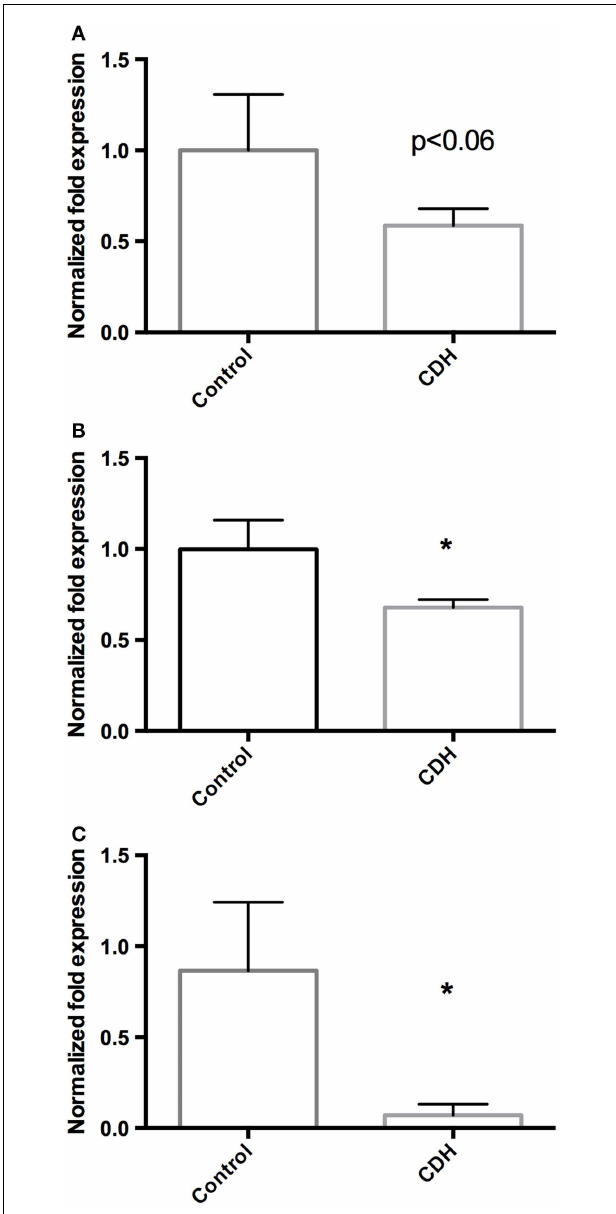
FIGURE 3 | (A) Wnt2 mRNA expression normalized to 18S.Wnt2 expression was decreased in CDH lungs ( n = 3) compared with controls ( n = 5, p < 0.06), (B) BMP4 mRNA expression normalized to 18S. BMP4 expression was significantly decreased in CDH lungs ( n = 3) compared with controls ( n = 5, * p < 0.05), (C) LGL1 mRNA expression normalized to 18S. LGL1 expression was significantly decreased in CDH lungs ( n = 3) compared with controls ( n = 5, * p <